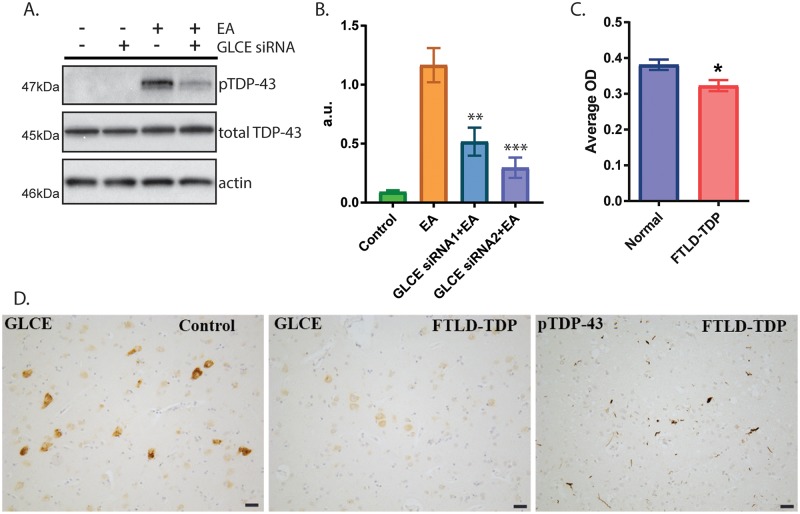
GLCE changes in mammalian cultured cells and in FTLD-TDP.(A-B) Cultured HEK293 cells treated with ethacrynic acid (EA) accumulate robust levels of phosphorylated TDP-43. (A) Representative immunoblots of cells treated with GLCE-targeted siRNA exhibit reduced pTDP accumulation in the presence of EA. (B) Triplicate independent experiments were quantified and graphed. Significance was evaluated using one-way analysis of variance with Tukey’s multiple comparison test among strains tested. **p = 0.0029, ***p = 0.0002 versus EA treated. (C-D) GLCE immunoreactivity is reduced in patients with FTLD-TDP compared with normal controls. (C) Quantitation of GLCE immunoreactivity in the deep layers of the frontal cortex (mid-frontal gyrus) from 14 patients with FTLD-TDP and 12 normal controls. Significance was evaluated using an unpaired t-test, *p = 0.0116. (D) Representative images of GLCE immunostaining in the frontal cortex of patients and controls. pTDP-43 accumulation is apparent in FTLD-TDP patients in this same brain region. Scale bar = 50um.